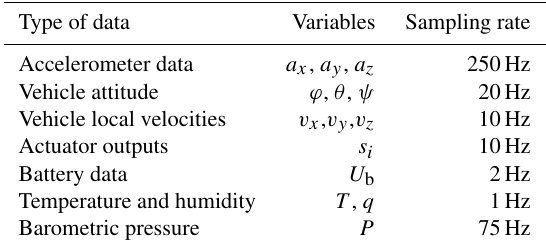
Table 1. Sensor data overview and initial raw sampling